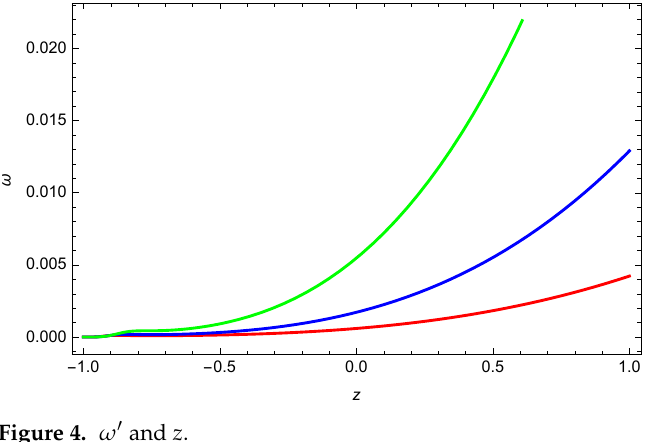
Figure 4. ω (cid:48) and z